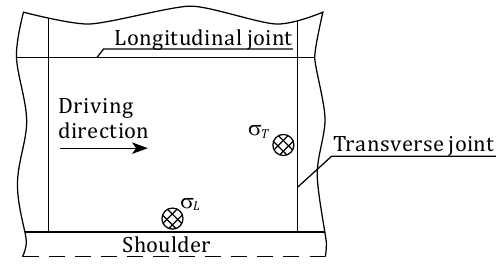
Figure 4. Locations for the estimation of bending moment in the slab